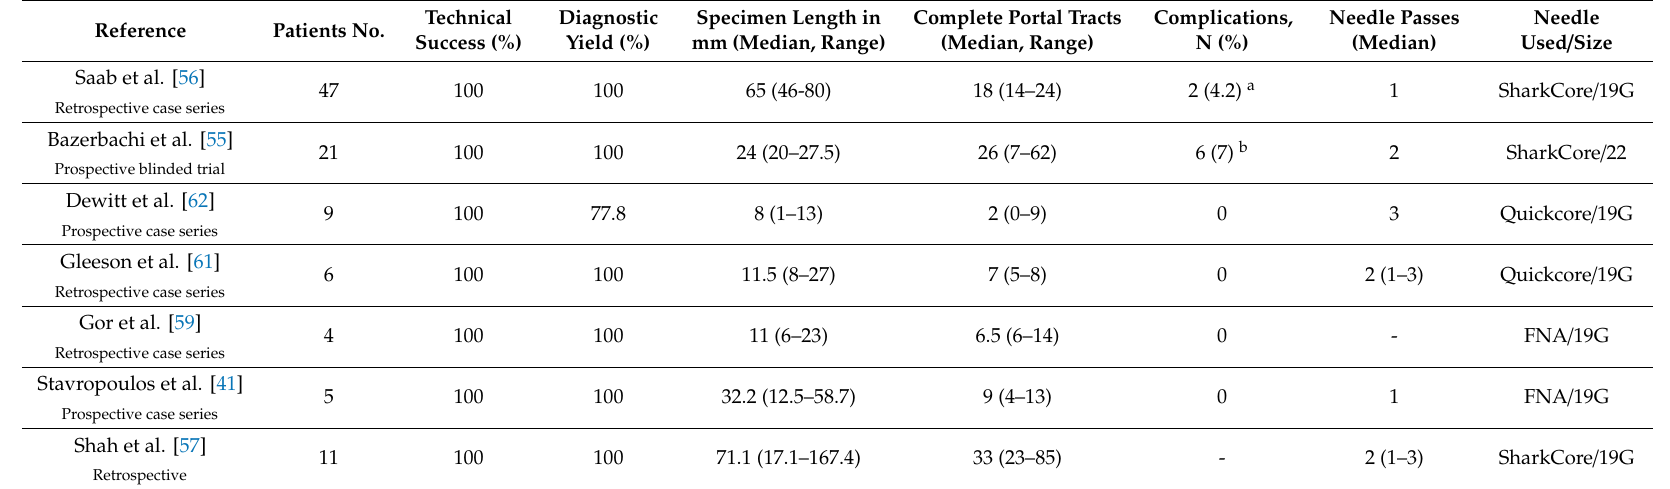
Table 4. Studies reporting the e ffi cacy and safety of EUS-guided liver biopsy in non-alcoholic fatty liver